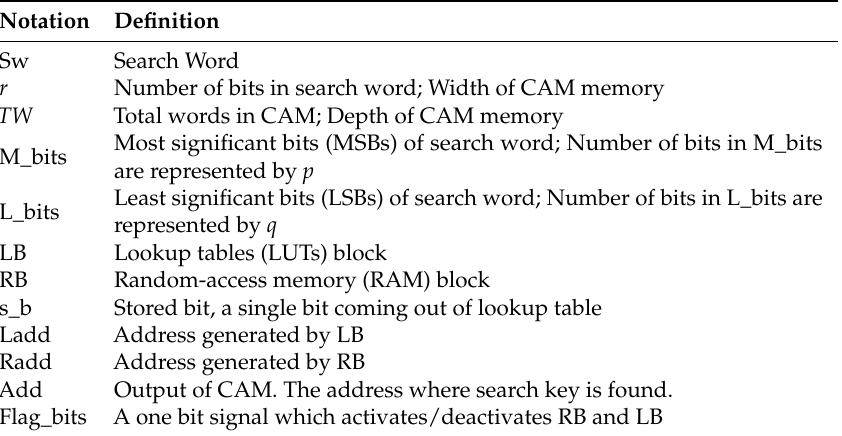
Table 1. Different Terminologies